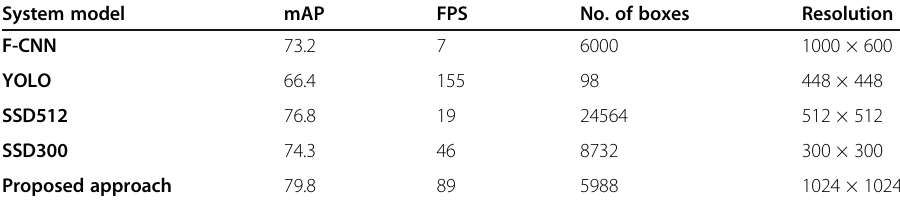
Table 3 represents the different values of mAP on Pascal VOC and COCO